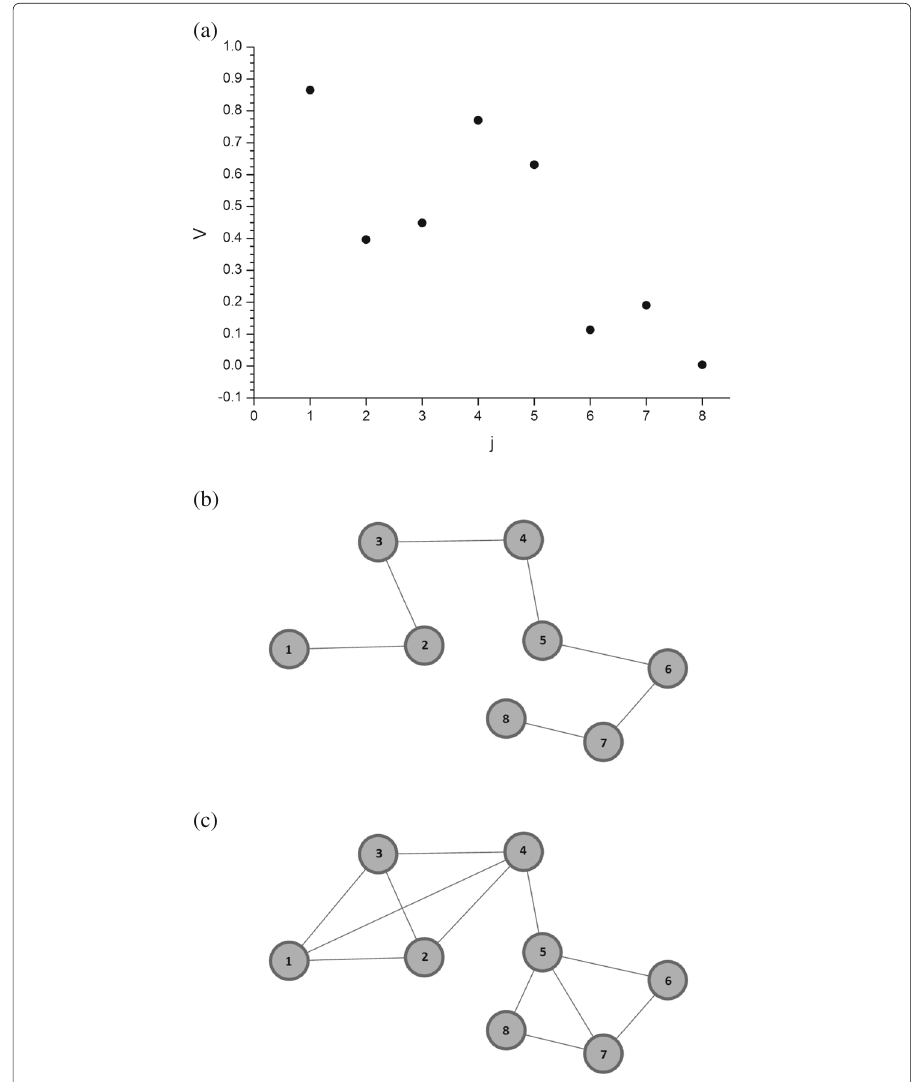
Fig. 1 Example of a series transformed into a visibility graph. Source: Author. a Series V containing eight points b Visibility mapping of consecutive points in V - Hamiltonian path c Visibility mapping of